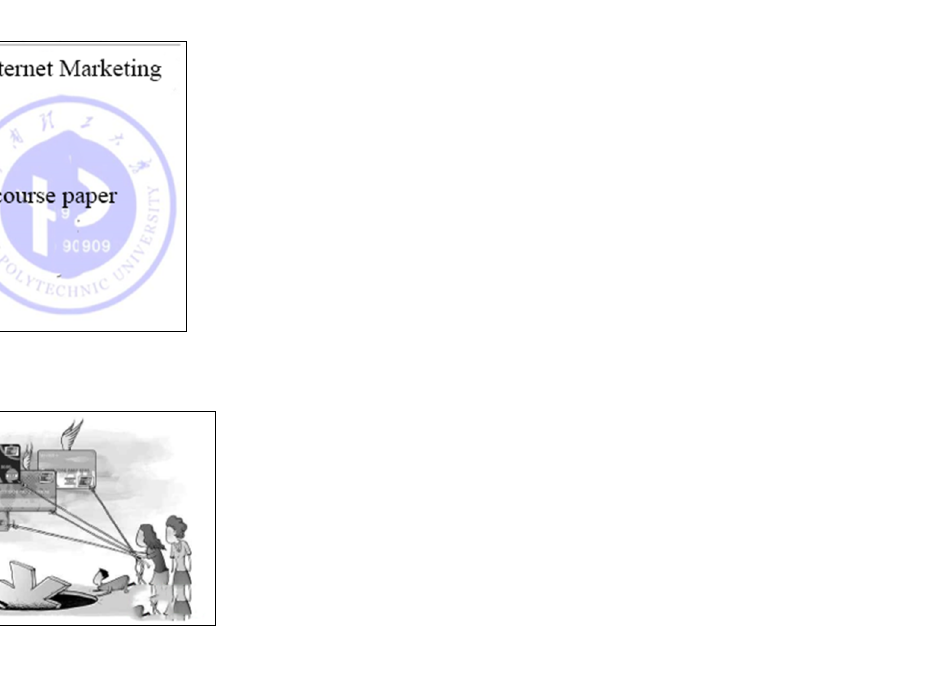
Figure 8. Image example. In the figure ( a , b ) images have formulas and a small amount of text, ( c , d ) images contain only mathematical formulas, ( e – h ) images are cases in which formulas are interspersed with text, the ( f ) image contains only text, and ( i – l ) images do not contain mathematical formulas.